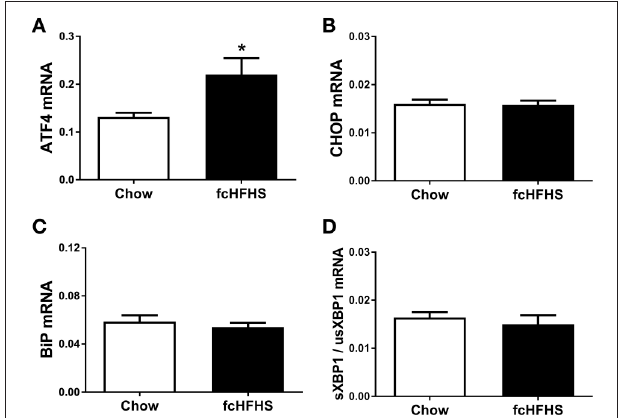
FIGURE 1 | ER stress markers in rat hypothalamus after 1 week ad libitum fcHFHS diet or chow. (A) ATF4 and (B) CHOP (C) BiP, and (D) sXBP1/usXBP1 mRNA expression. mRNA expression of specific genes was normalized to the geometric mean of three housekeeping genes. Significant differences between the fcHFHS and control group: * p < 0.05.